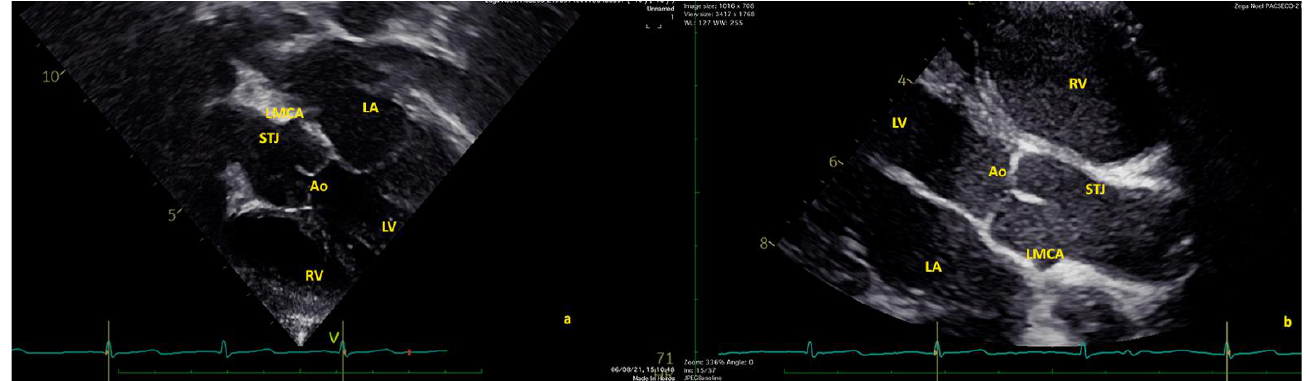
Figure 4. High left main coronary artery (LMCA) origin in modified four-chamber view ( a ) and in classical short-axis view; ( b ) angle of origin of the patient at 130° in short-axis view. Ao = aorta; LA = left atrium; LMCA = left main coronary artery; LV = left ventricle; STJ = sinotubular junction; RV = right ventricle.